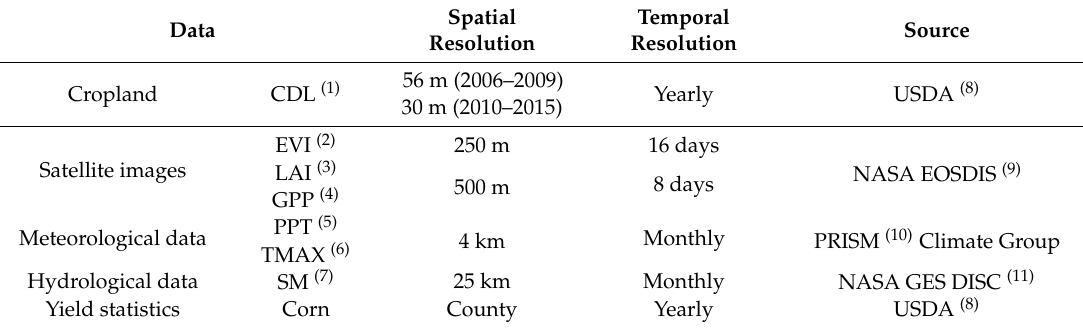
Table 1. The data used for corn yield prediction.